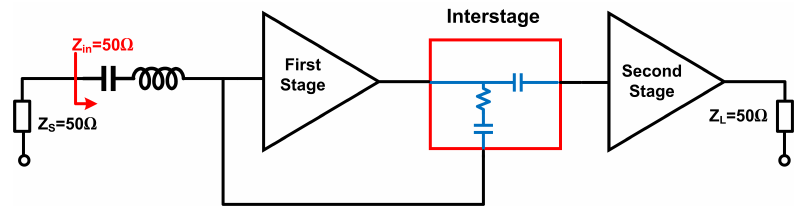
Figure 1. Block diagram of suggested ultra-wideband (UWB) power